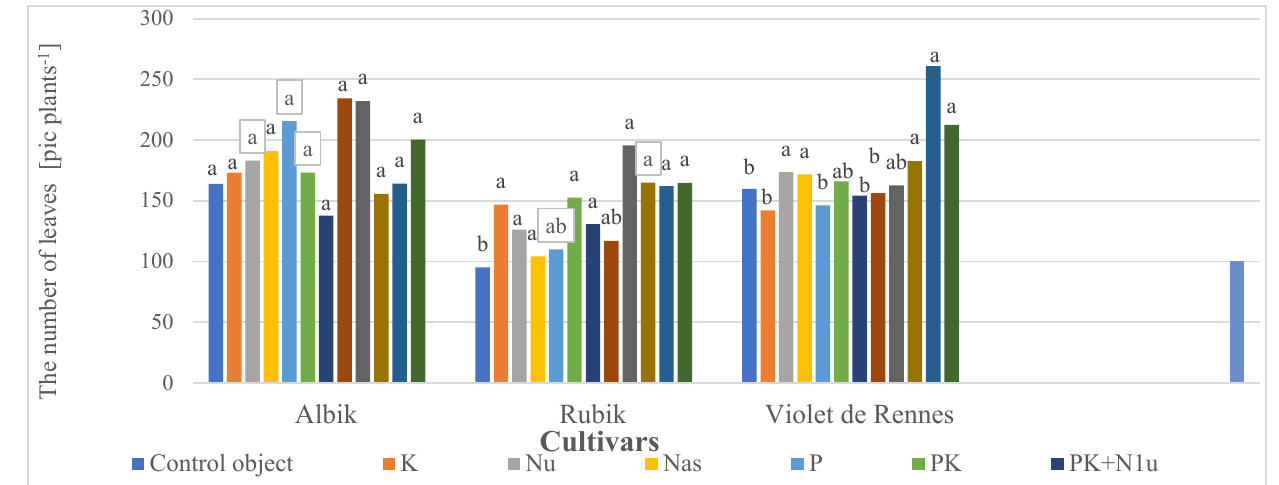
Figure 5. The effect of mineral fertilization and cultivar properties on the number of leaves (2016–2018); designations as in Table 5. Legend: control object ‒ N 0 P 0 K 0 ; P ‒ 43 kg P . ha − 1 ; K ‒ 124 kg K . ha − 1 ; as ‒ ammonium sulfate; u ‒ urea; Nu and Nas ‒ 100 kg N . ha − 1 ; PK ‒ P 43 K 124 ; N1 ‒ 50 kg N . ha − 1 ; PK+N1 ‒